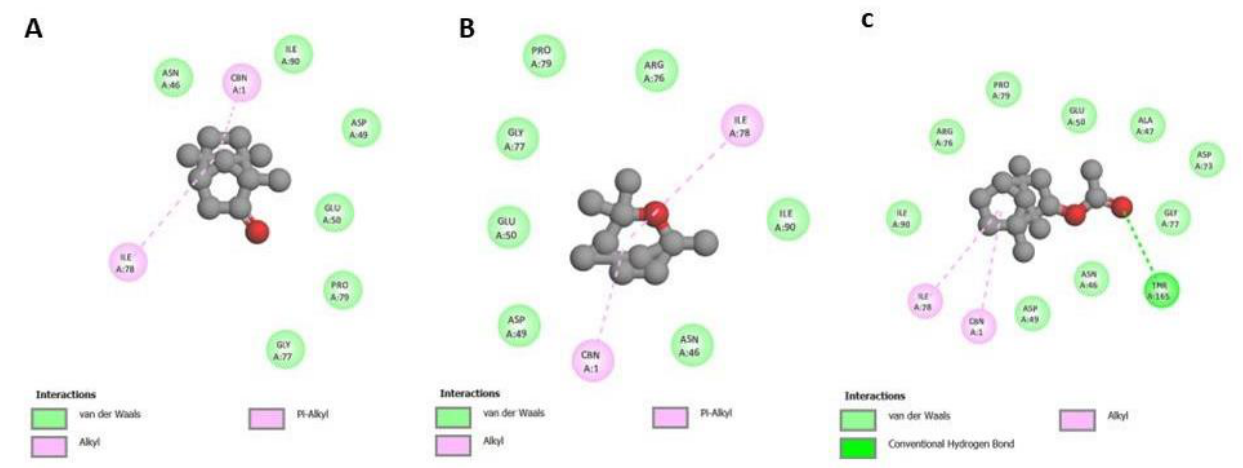
Figure 3. 2D scheme of TyrRS interaction with the tested ligands ( A ) Eucalyptol; ( B ) Camphor; ( C ) Bornyl acetate.